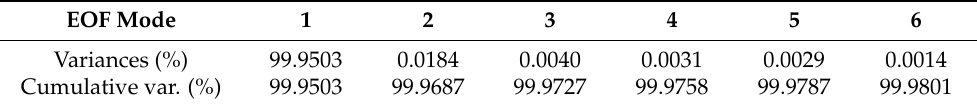
Table 1. Summary of the variance through decomposition of SH coefficients under the first six-order EOF mode. EOF Mode 1 2 3 4 5 6 Variances (%) 99.9503 0.0184 0.0040 0.0031 0.0029 0.0014 Cumulative var. (%) 99.9503 99.9687 99.9727 99.9758 99.9787